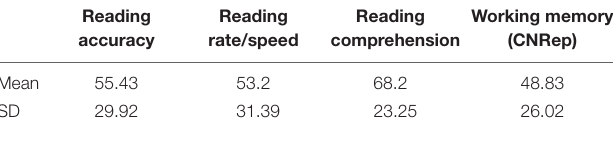
TABLE 2 | Descriptive statistics reading and memory tasks